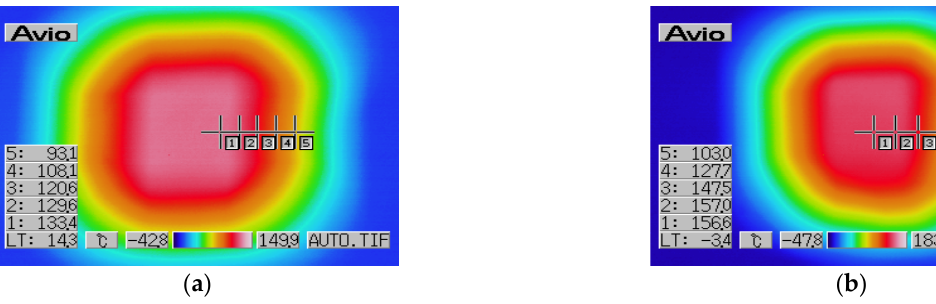
Figure 4. Heat distribution of the center point of 100 μ m thickness at 30 min: ( a ) Coating plane; ( b ) SUS304 plane.